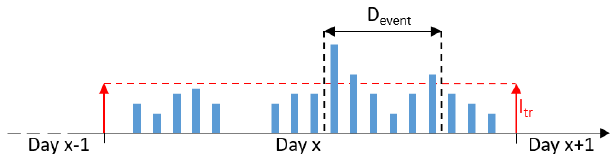
Figure 5. Scheme for extreme rainfall event